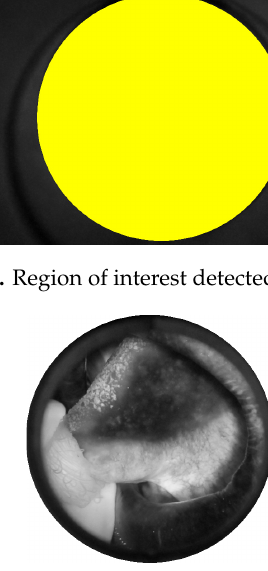
Figure 14. Oral cavity region extracted without the VELscope ® device.